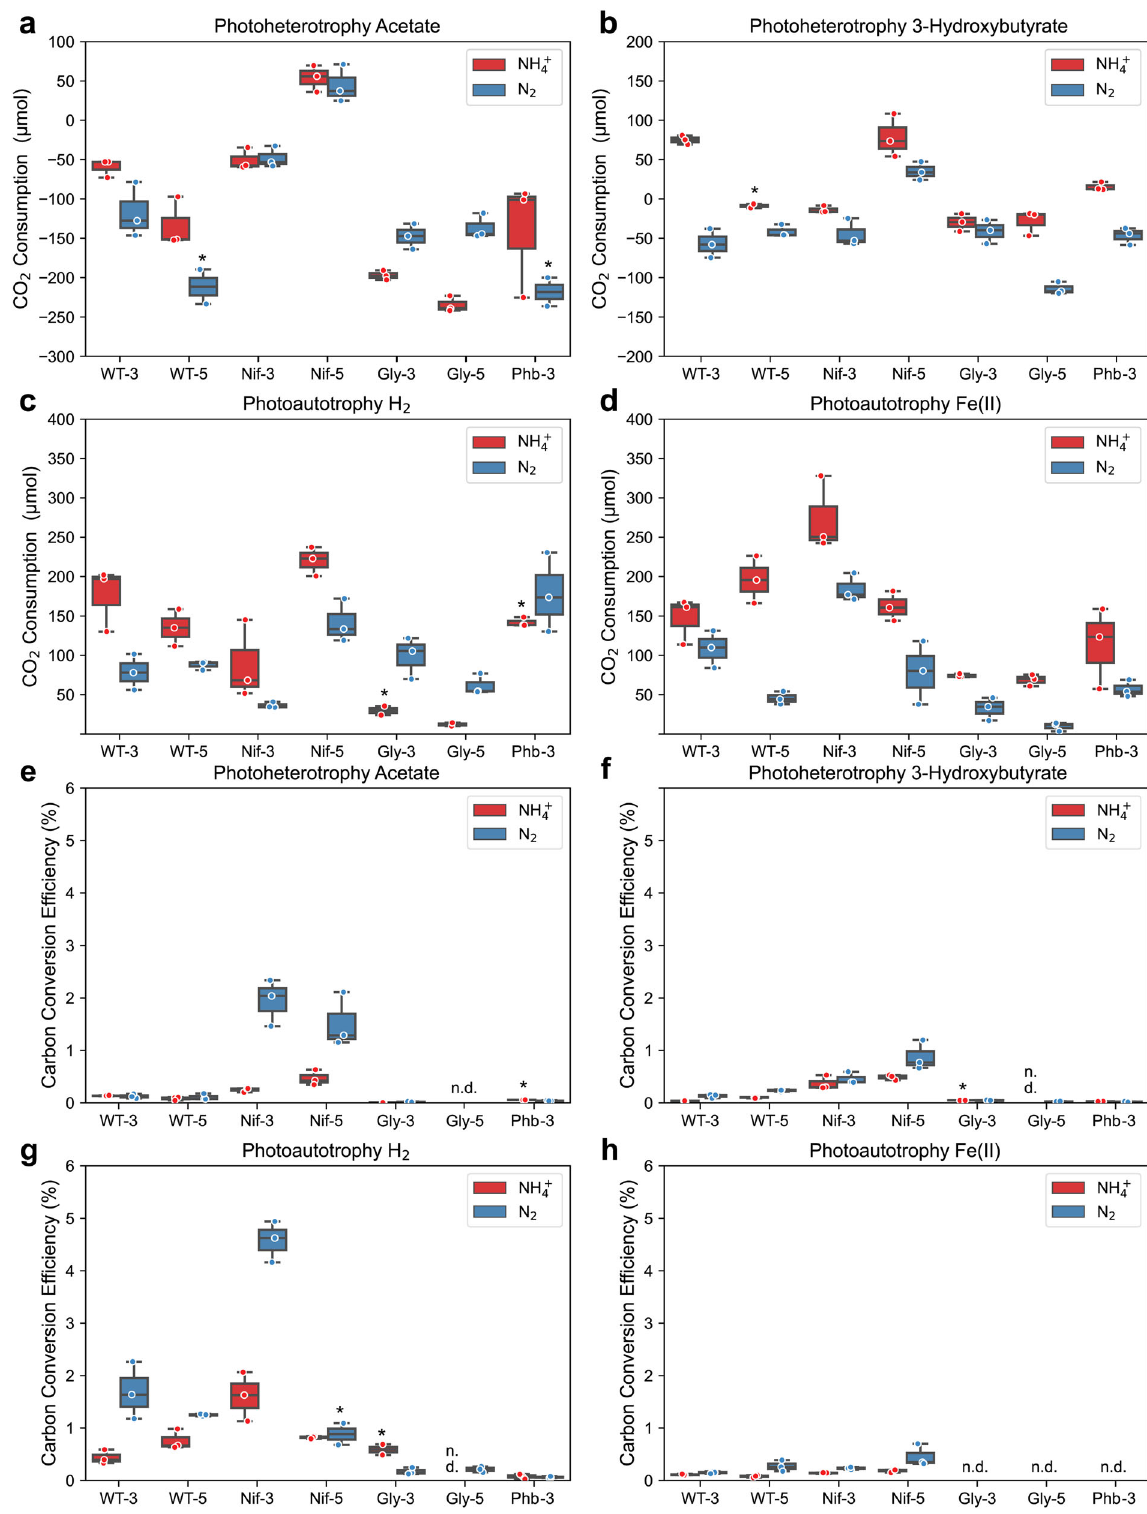
Fig. 5 The nitrogenase double mutant (Nif) converts carbon to n -butanol more ef fi ciently. a – d The CO 2 consumption (positive value)/production (negative value). e – h Carbon conversion ef fi ciency to n -butanol. a , e : acetate (photoheterotrophy) b , f : 3-hydroxybutyrate (photoheterotrophy) c , g : hydrogen (H 2 ) (photoautotrophy) and d , h : ferrous iron [Fe(II)] (photoautotrophy). CO 2 was present in all conditions. Data are from n = 3 of independent experiments. WT-3: wild type with 3-gene cassette; WT-5: wild type with 5-gene cassette; Nif-3: nitrogenase knockout with 3-gene cassette; Nif-5: nitrogenase knockout with 5-gene cassette; Gly-3: glycogen synthase knockout with 3-gene cassette; Gly-5: glycogen synthase knockout with 5-gene cassette; Phb-3: hydroxybutyrate polymerase knockout with 3-gene cassette, n.d. non-detectable.